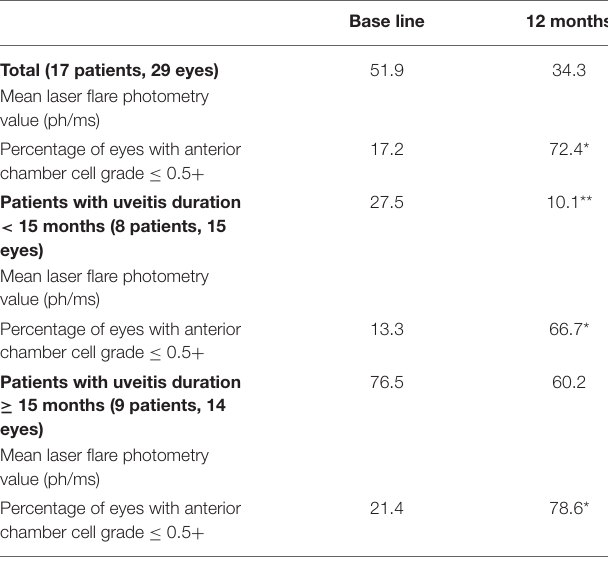
TABLE 4 | Change in laser flare photometry values and inflammatory variables according to uveitis duration before methotrexate therapy. Base line 12